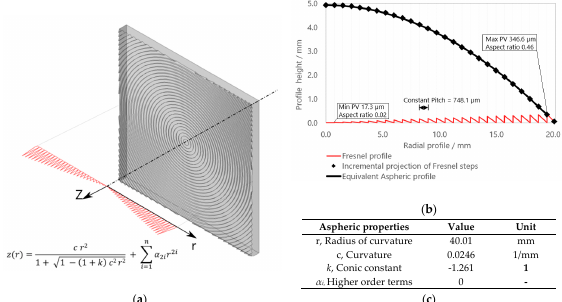
Figure 2. Representation of the studied Fresnel lens: ( a ) 3D view of the flat, squared, 40 mm × 40 mm Fresnel surface aperture, with a section view of the axis-symmetric radial profile, which follows a stepped aspheric profile as described by the conic equation; ( b ) a highlight of the section profile in the z , r plane with indication of the peak-to-valley (PV) nominal specifications in comparison with the equivalent continuous aspheric curvature; ( c ) summary table of the aspheric properties of the considered lens.